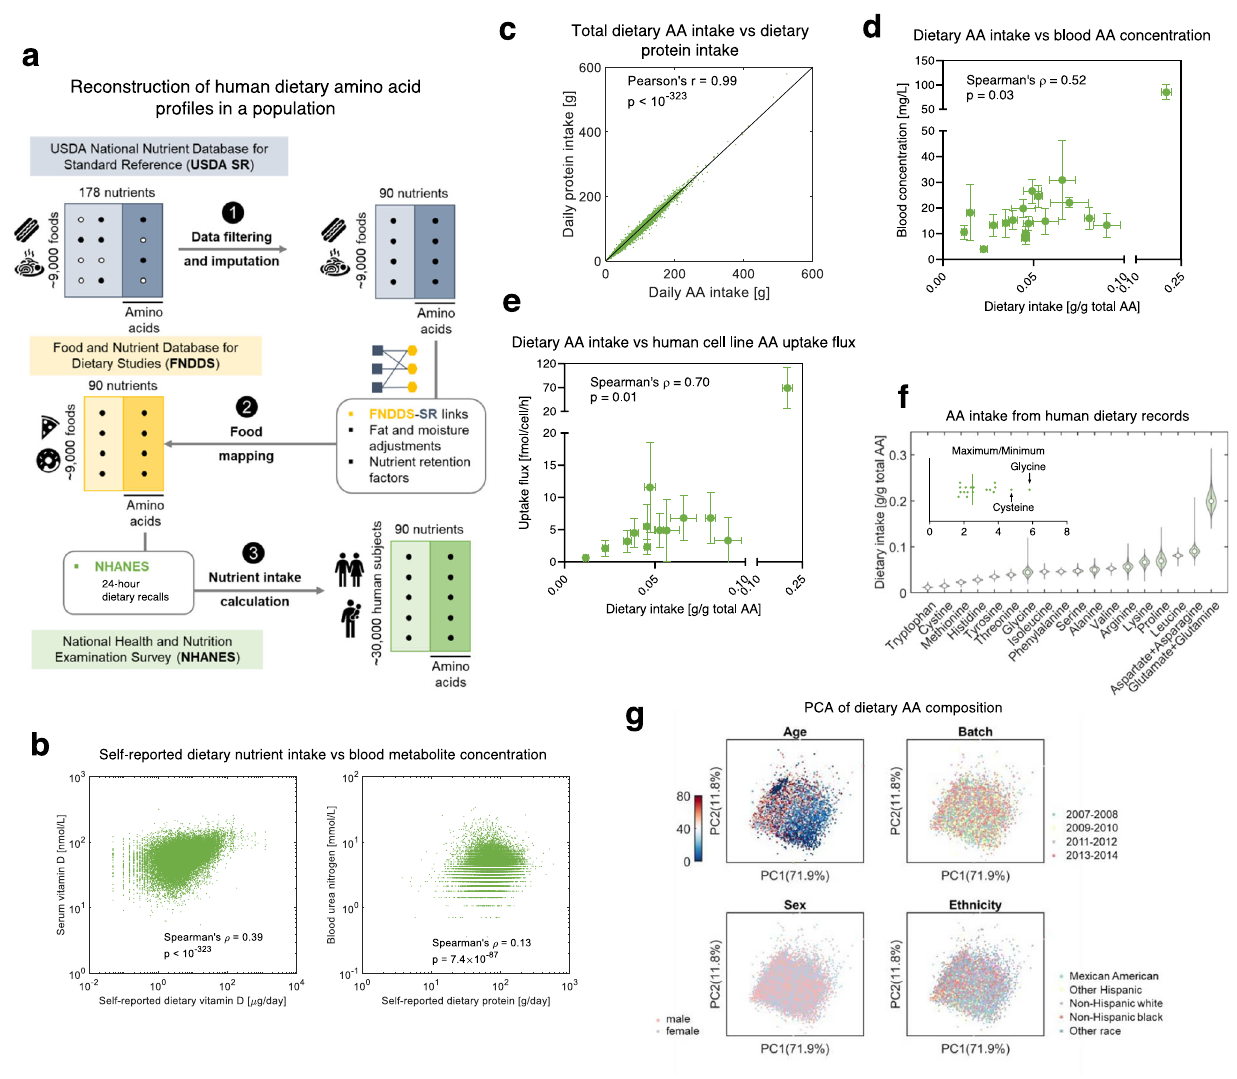
Fig. 3 | Landscape of human dietary amino acid intake. a Work fl ow for recon- struction of the databaseconsisting of amino acid intake pro fi les in humandietary data. Food images used with permission from Microsoft. b Comparison between nutrient intake values in the self-reported dietary data and laboratory measure- ments of nutrient-related metabolites in blood. A two-sided Spearman ’ s rank cor- relation test was performed to compute the p-value. c Comparison between total dietary amino acid intake in the reconstructed amino acid intake database and dietaryproteinintakeintheoriginaldietarydata.Atwo-sidedPearson ’ scorrelation test was used to compute the p-value. d Comparison of the reconstructed human dietary amino acid intake values to blood concentrations of amino acids. The dots represent for mean values and error bars for standard deviations. A two-sided